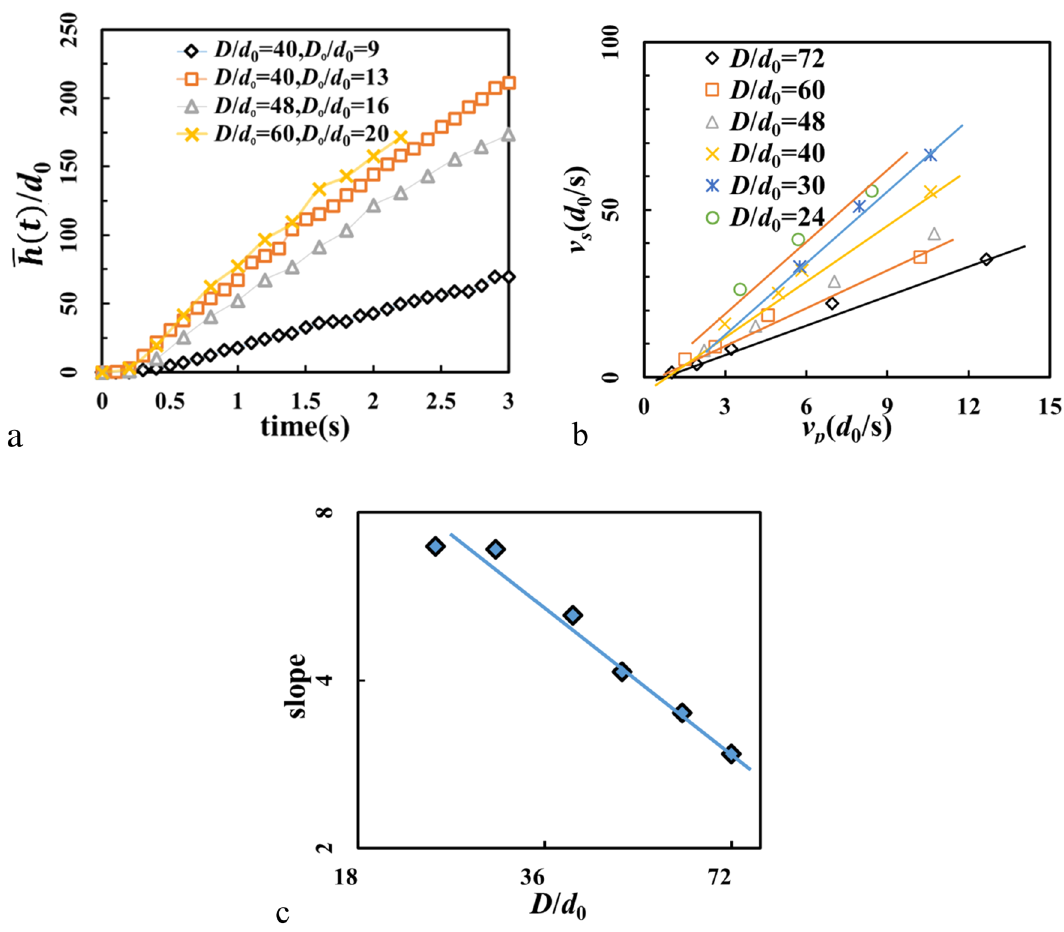
¯ h ( t ) ) with different D and D 0 . ( b ) The relation